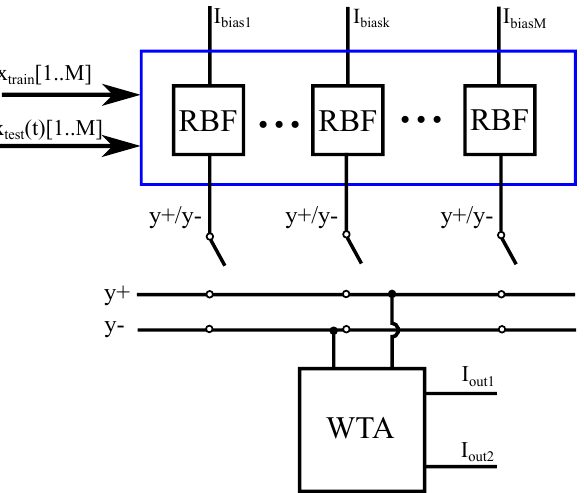
Figure 3. The prediction block of the classifier (classification block). The RBF cells receive the input and produce the appropriate RBF functions based on the trained parameters. These RBF functions represent the support vectors. The sign of the support vectors is imported to the classification block by the switches. The WTA is used to compare the positive and the negative